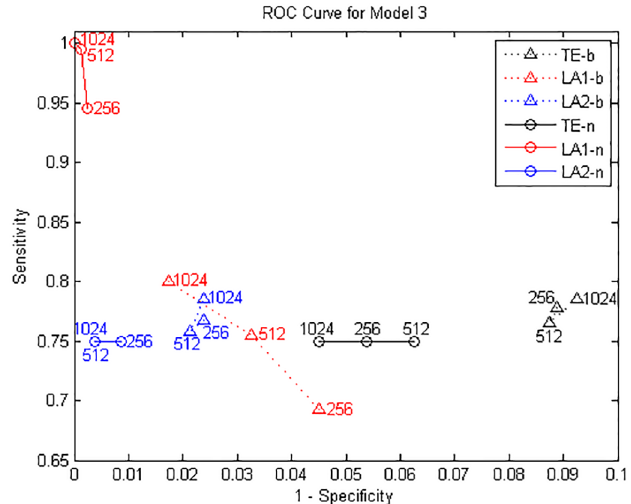
Fig 6. ROC curves for Model C. TE-b/LA1-b/LA2-b are the results by binning entropy estimator and TE-n/LA1-n/ LA2-n by NN entropy estimator, sensitivity and specificity are obtained by gradually increasing the time series length from 256 to 1024